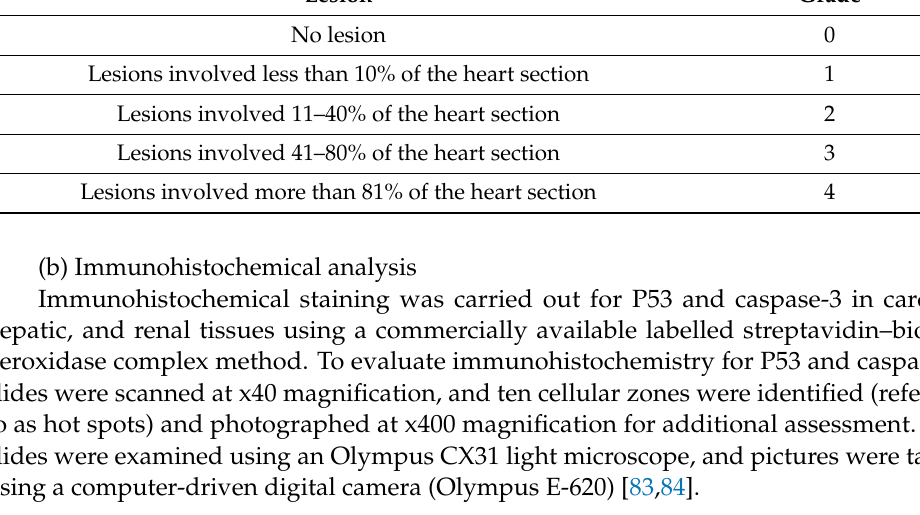
Table 5. Scoring features for degenerative myocardial changes. Lesion Grade No lesion 0 Lesions involved less than 10% of the heart section 1 Lesions involved 11–40% of the heart section 2